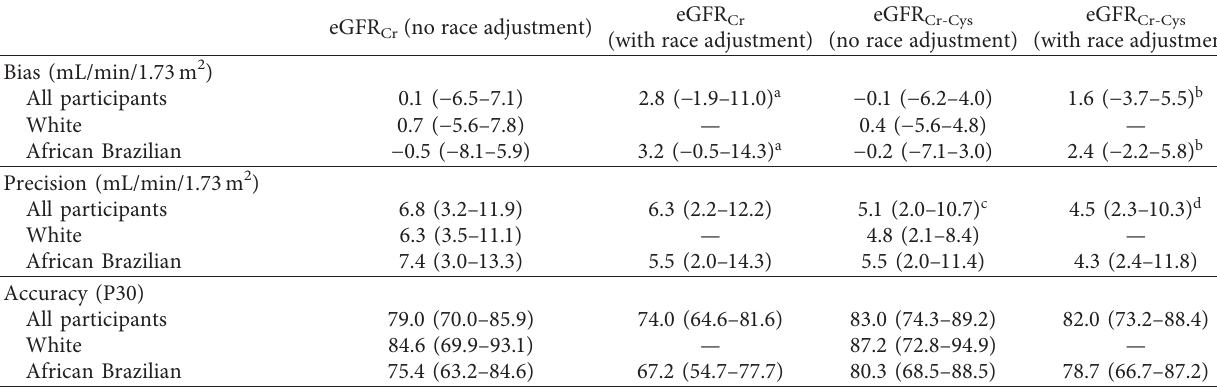
Table 5: Performance of the equations for estimation of GFR.